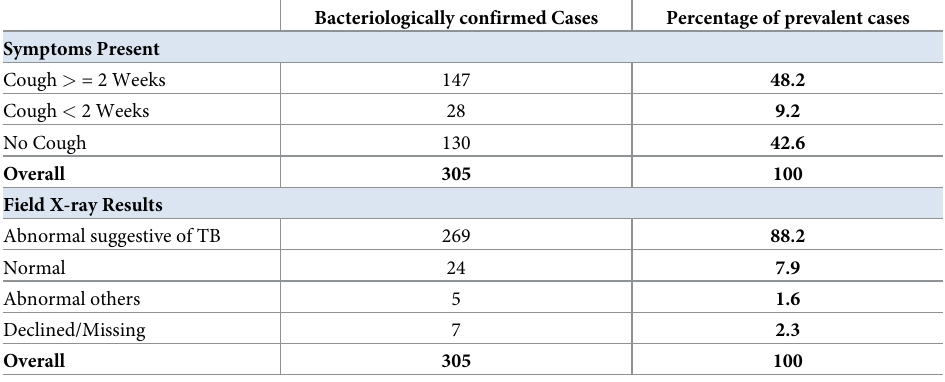
Table 4. Proportions of prevalent cases by screening methods (symptoms and chest